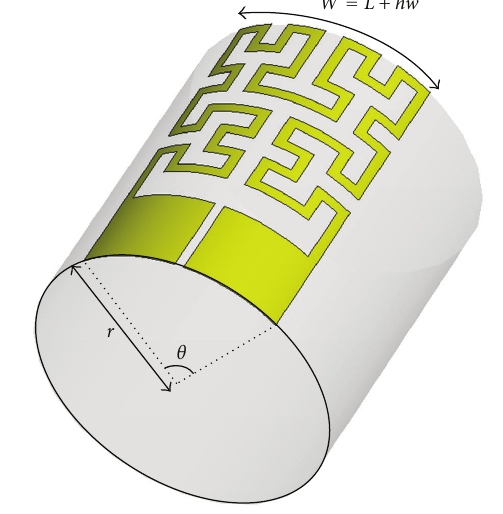
Figure 3: Geometry of the flexible Hilbert-curve loop antenna and radius of its curvature.